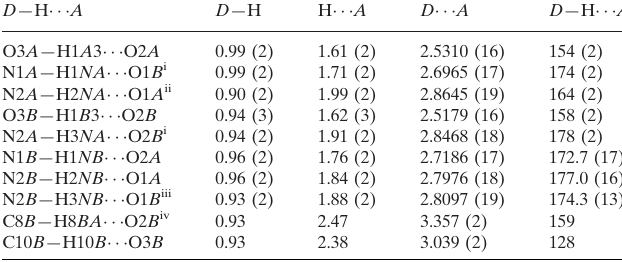
Hydrogen-bond geometry (A˚ , (cid:4)